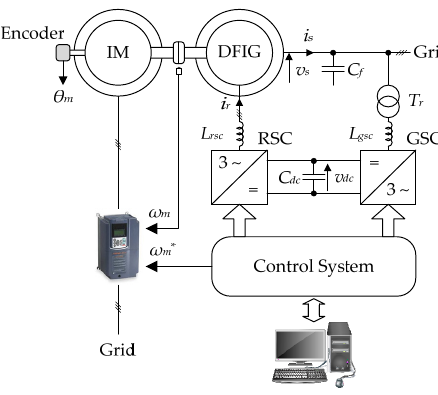
Figure 8. Schematic diagram of the experimental setup. Table 1. Parameters of the DFIG.